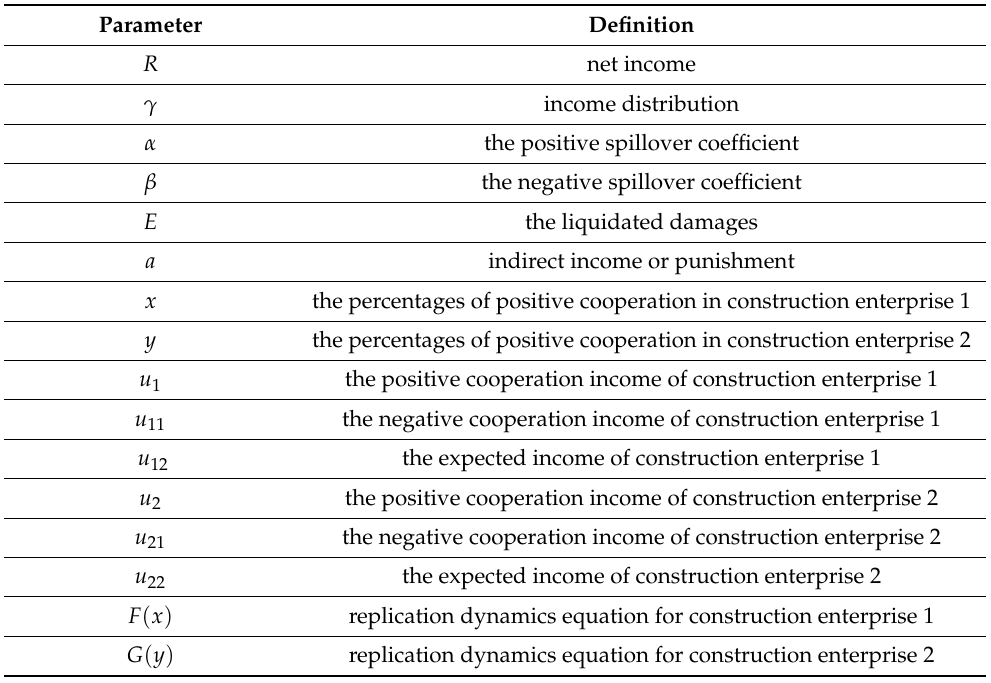
Table 2. Parameter